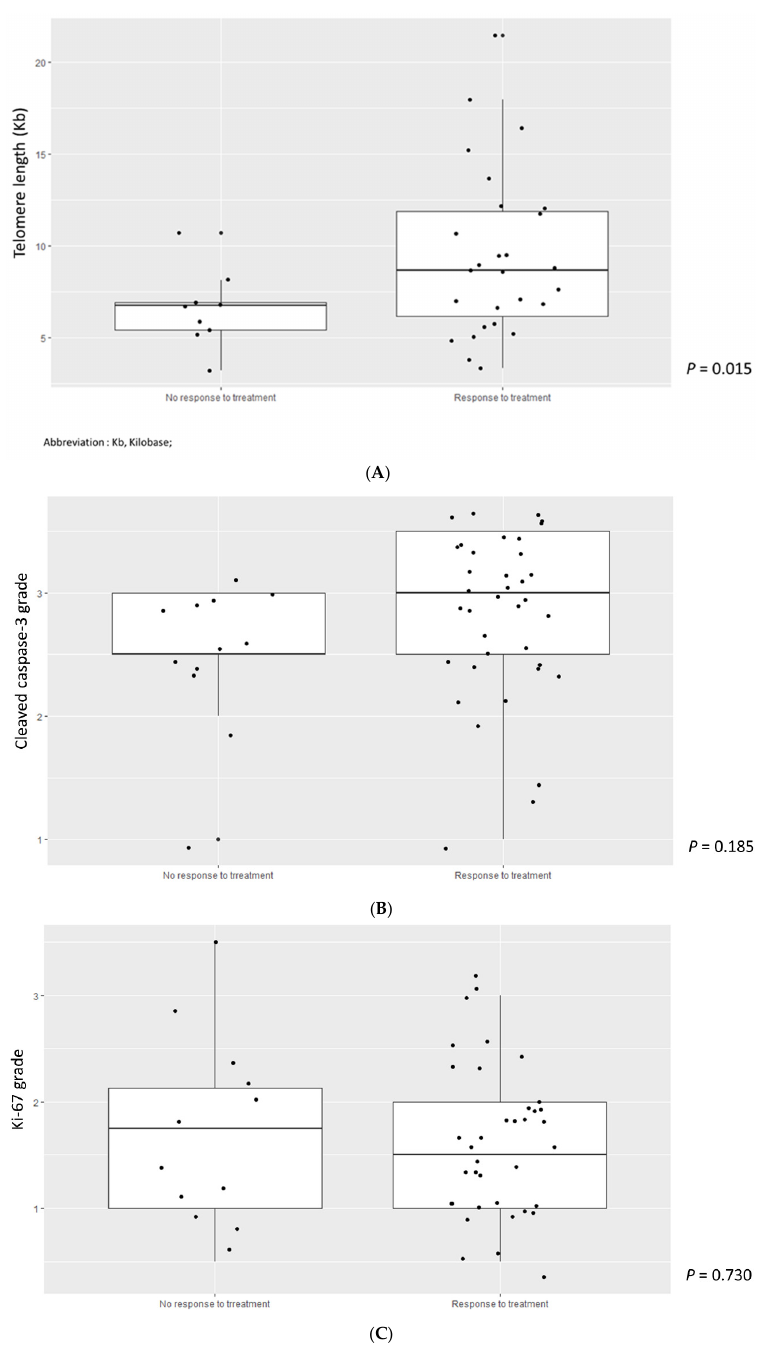
Figure 5. ( A ) Telomere length according to response to treatment. Abbreviation: Kb, kilobase. ( B ) Cleaved caspase-3 grade according to response to treatment. ( C ) Ki-67 grade according to response to treatment.